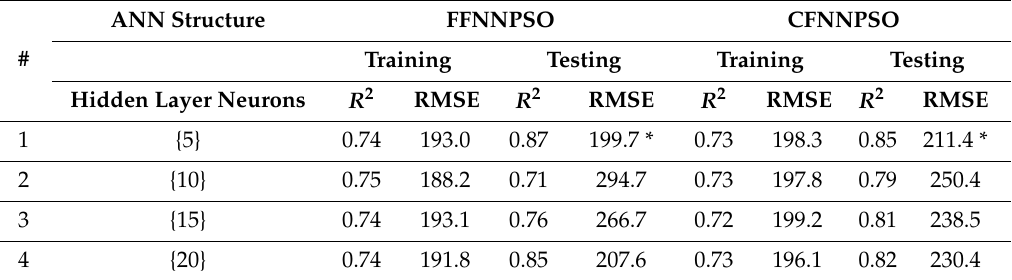
Figure 4. The best testing performance for the cascade-forward neural networks trained with particle swarm optimization (CFNNPSO) model ( R 2 = 0.88). Table 8. Results on FFNN and CFNN trained using PSO with 3 features ( x 1 , x 2 , x 4